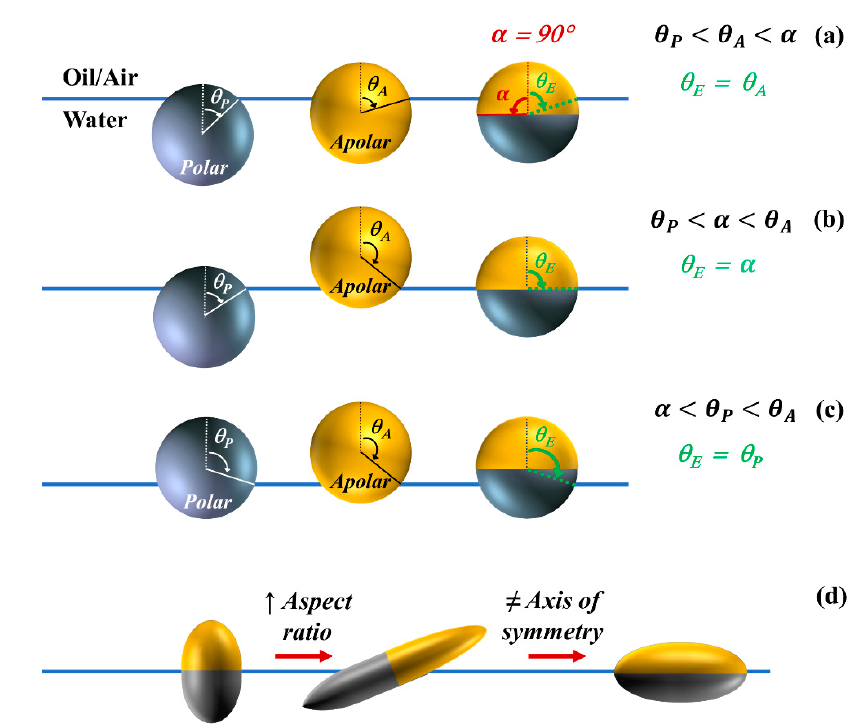
Figure 2. (Color online) Equilibrium configurations of a Janus particle residing at a fluid/fluid interface: the equilibrium contact angle ( a ) equaling the apolar contact angle (Equation (2)), ( b ) coinciding with the Janus boundary (Equation (3)), ( c ) equaling the polar contact angle (Equation (4)); ( d ) the impact of combined shape and surface anisotropy.